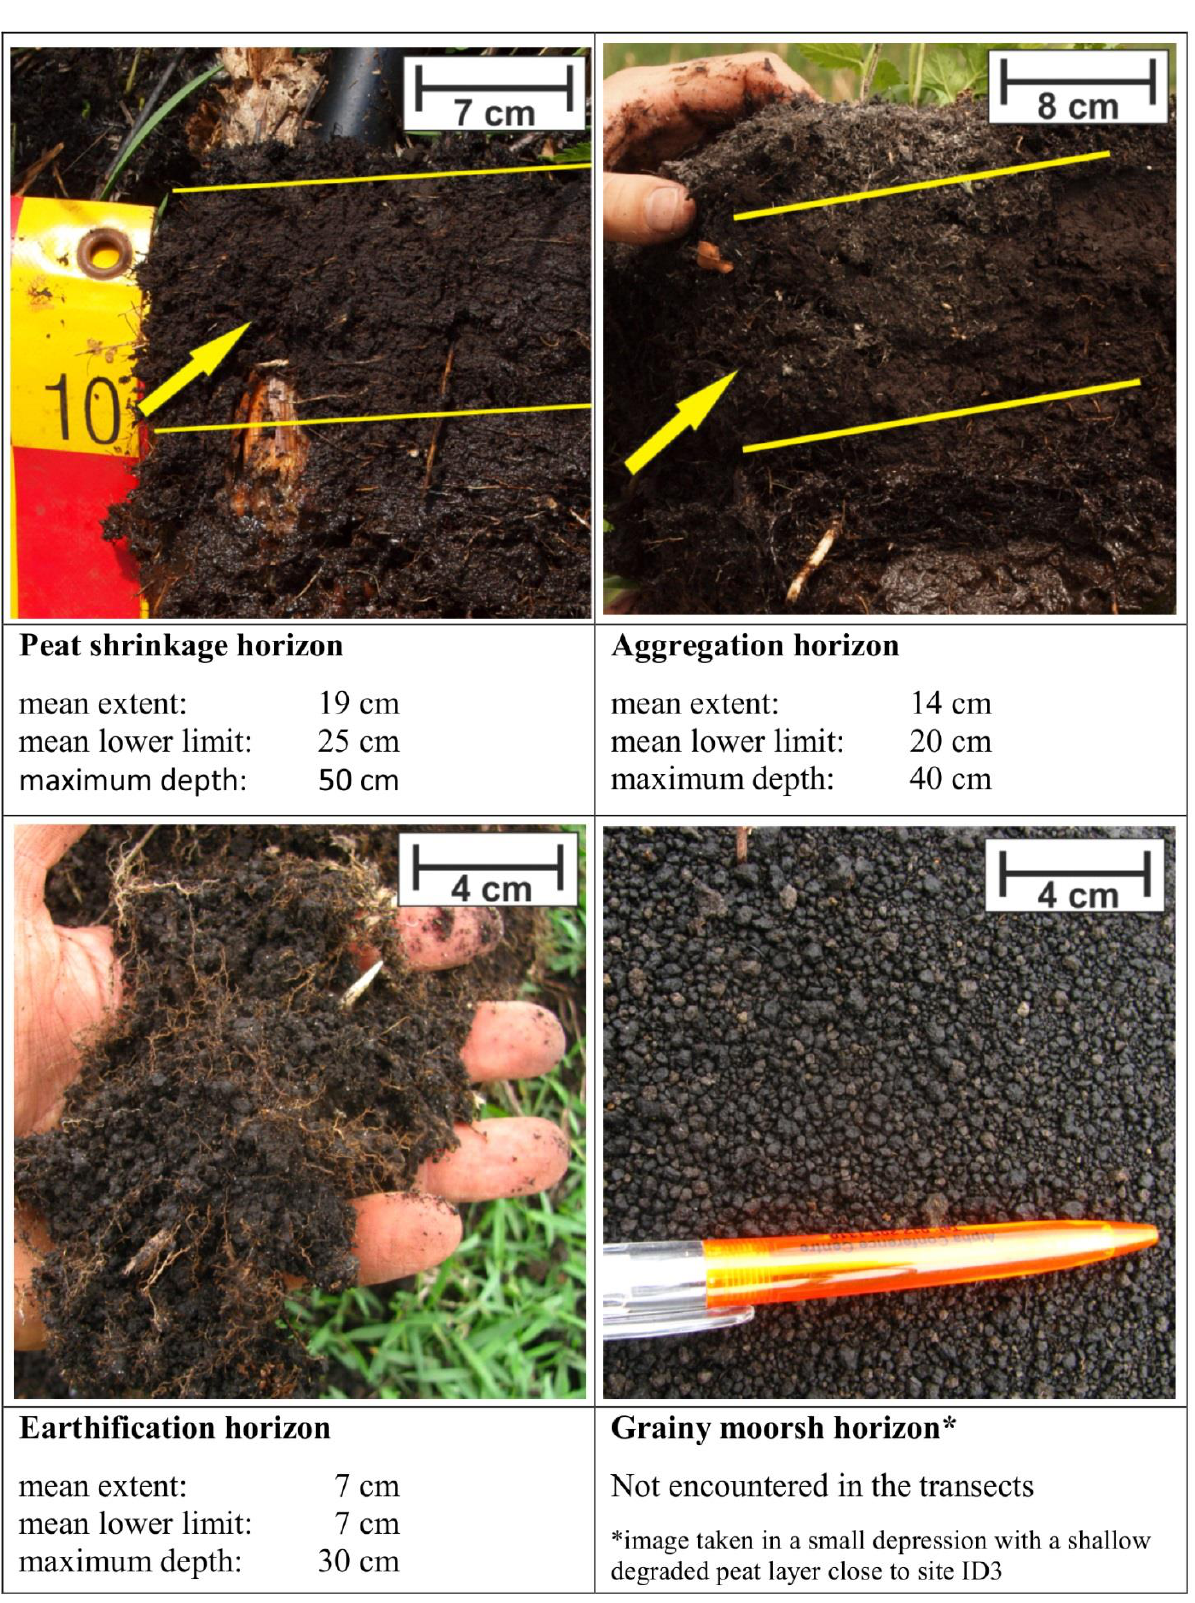
Figure 2. Appearance of the structure of degradation horizons. In the top two panes, the yellow lines indicate the upper and lower limits of the horizon described, and the yellow arrows point to